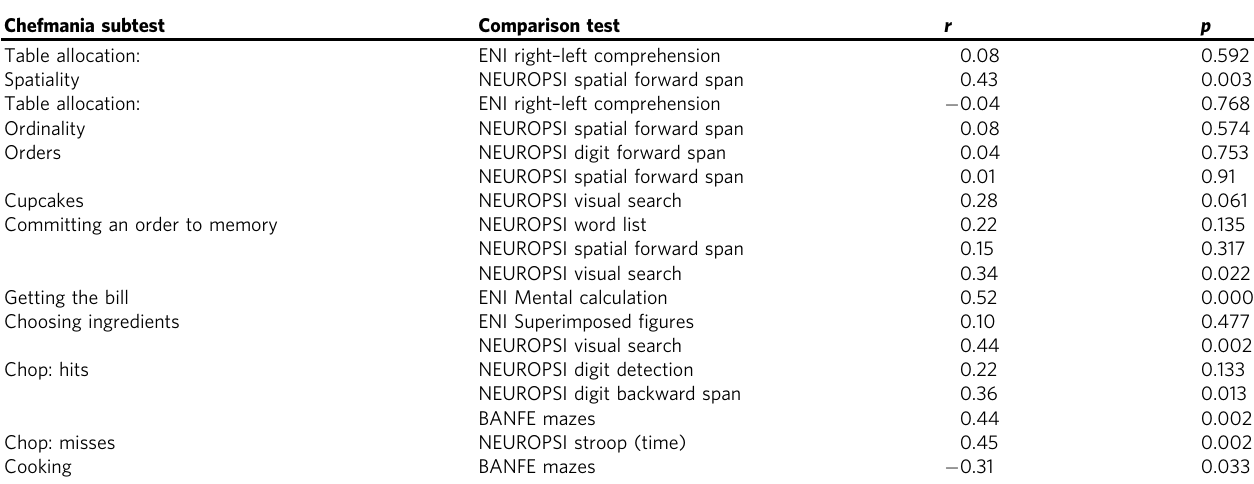
Table 3 Correlations between Chefmania and standardized tests scores.